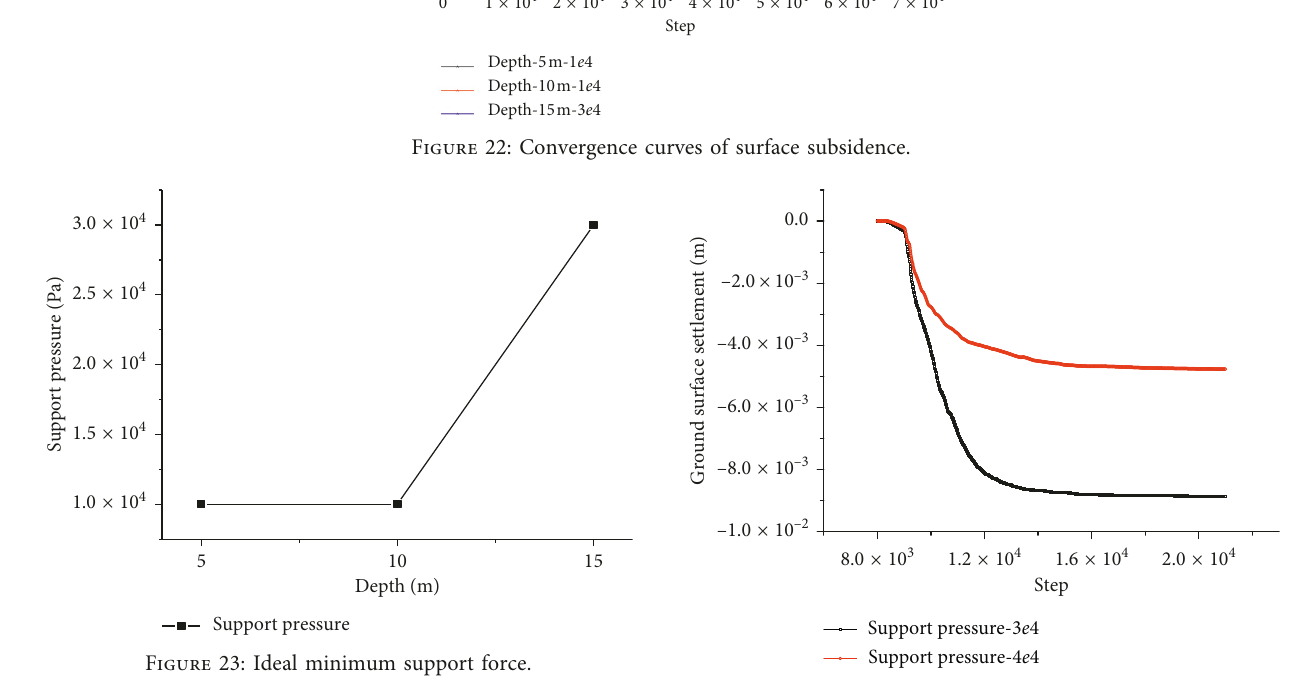
Figure 25: Displacement curve of 10m buried depth under dif- ferent supporting forces.